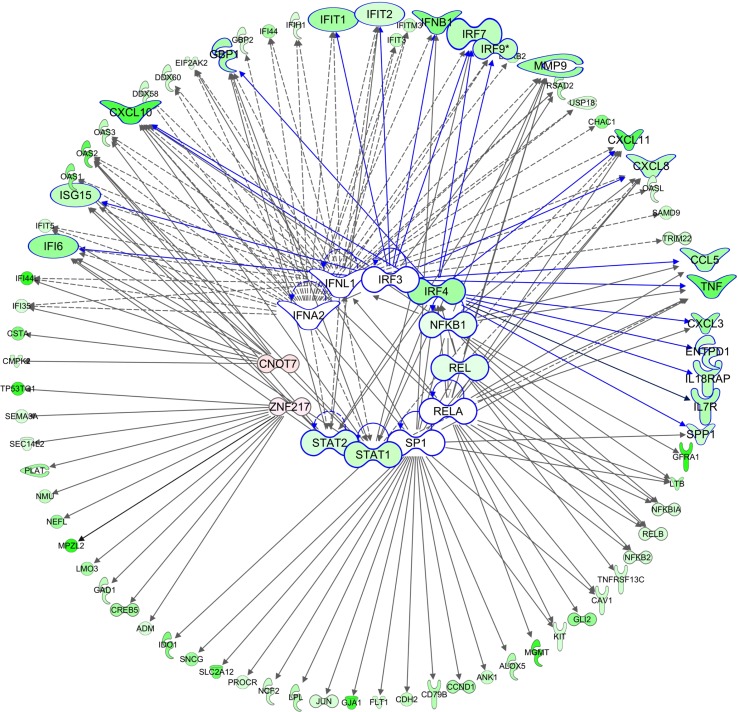
The top-ranked upstream transcription factors (in centre) suggested by IPA® for the set of down-regulated genes (outer circle).The top two-ranked cytokines, IFNA2 and IFNL1 are also included. Genes with >1.2 fold down-regulation are in green; those with >1.2-fold up-regulation are in red. Color intensity corresponds to the fold change. Genes corresponding to immediate downstream targets of IRFs are enlarged with blue borders and connections.